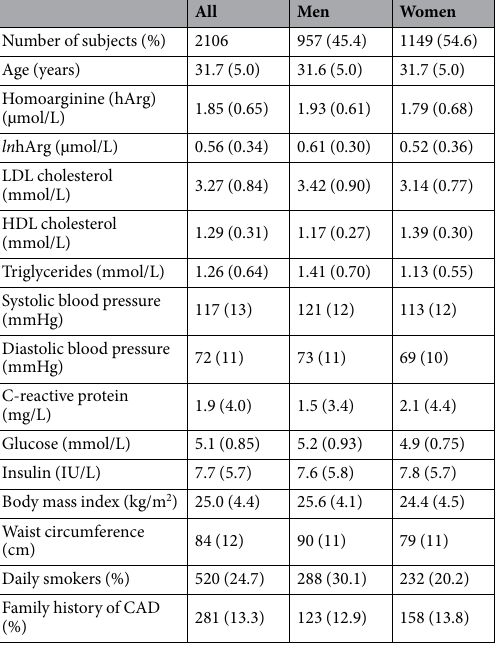
Table 1. Baseline descriptive data for the YFS cohort in 2001. Statistics are mean (SD) or n (%); ln hArg is natural log-transformed. CAD, coronary artery disease; LDL, low-density lipoprotein; HDL, high-density lipoprotein.